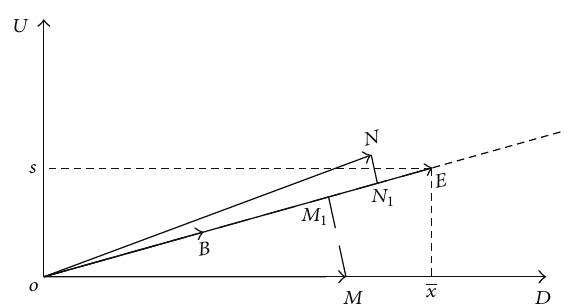
Figure 2: The relationship of different types of index vectors and the baseline index